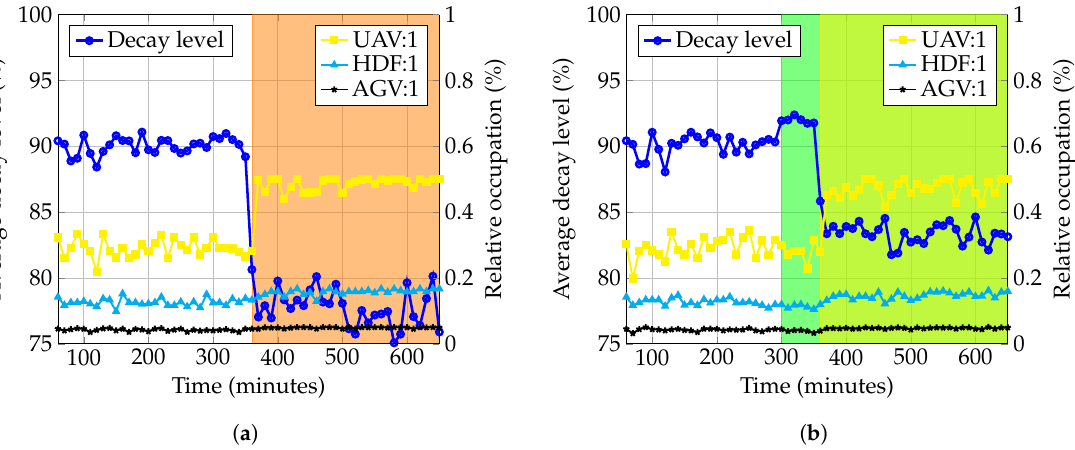
Figure 11. Macro- against micro-goals in disruptive scenarios. ( a ) With disruption after 6 h and an unchanged strategy. ( b ) With disruption after 6 h and a proactive mitigation